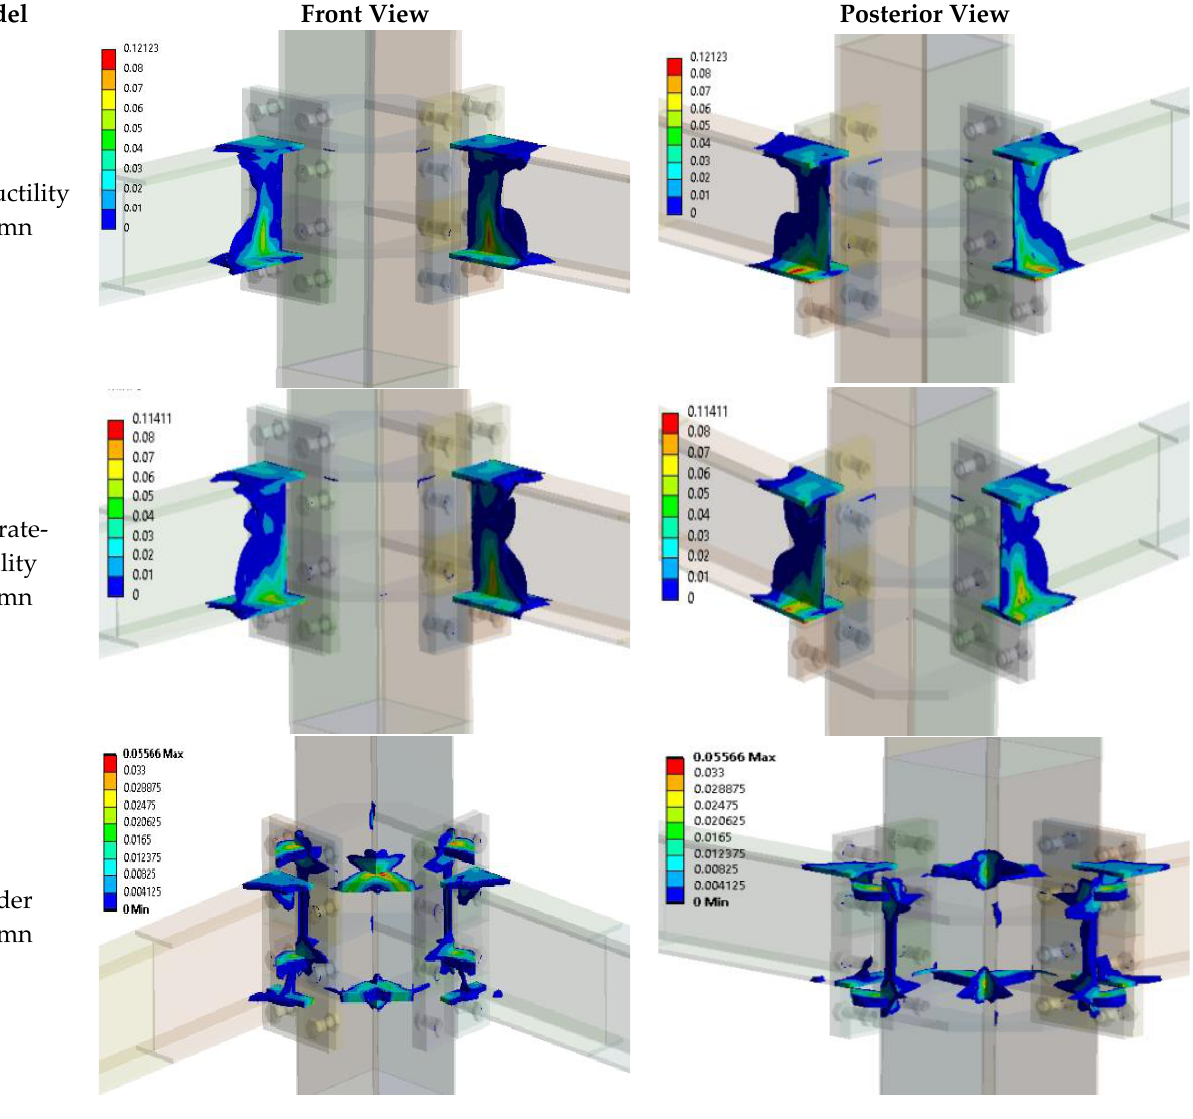
Figure 12. Plastic strain distributions in the 2BC models (Units: mm/mm). The 2BC slender column model shows an inelastic incursion meaningfully concen- trated in the outer annular stiffeners and its union with the column. However, a slight plastic strain appears in the flange of the beams instead of the failure mechanism controlled by the outer annular stiffeners. These stiffeners were designed to the maximum-concentrated beam flange force and had sufficient thickness to avoid high damage in the column and panel zones where plastic strain is not present.